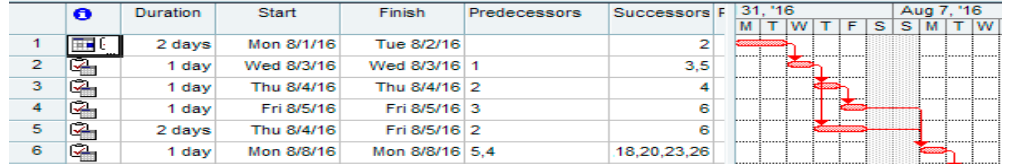
Figure 5. Illustrative part of gantographic display of the initial phase of the project to improve the environmental protection system in mining and energy complexes.